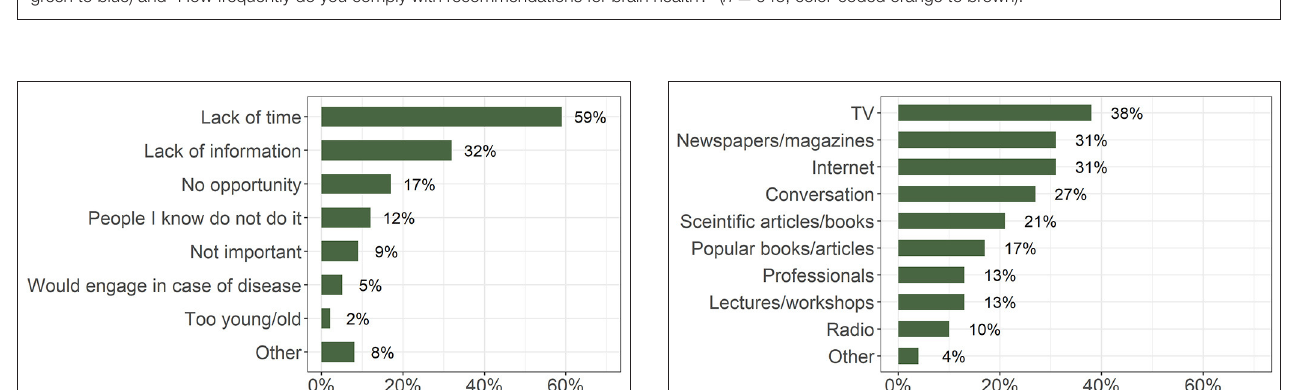
FIGURE 2 | Percentages of responses to the questions “How do you evaluate the following practices in terms of their value for brain health?” ( n = 945, color-coded green to blue) and “How frequently do you comply with recommendations for brain health?” ( n = 945, color-coded orange to brown).